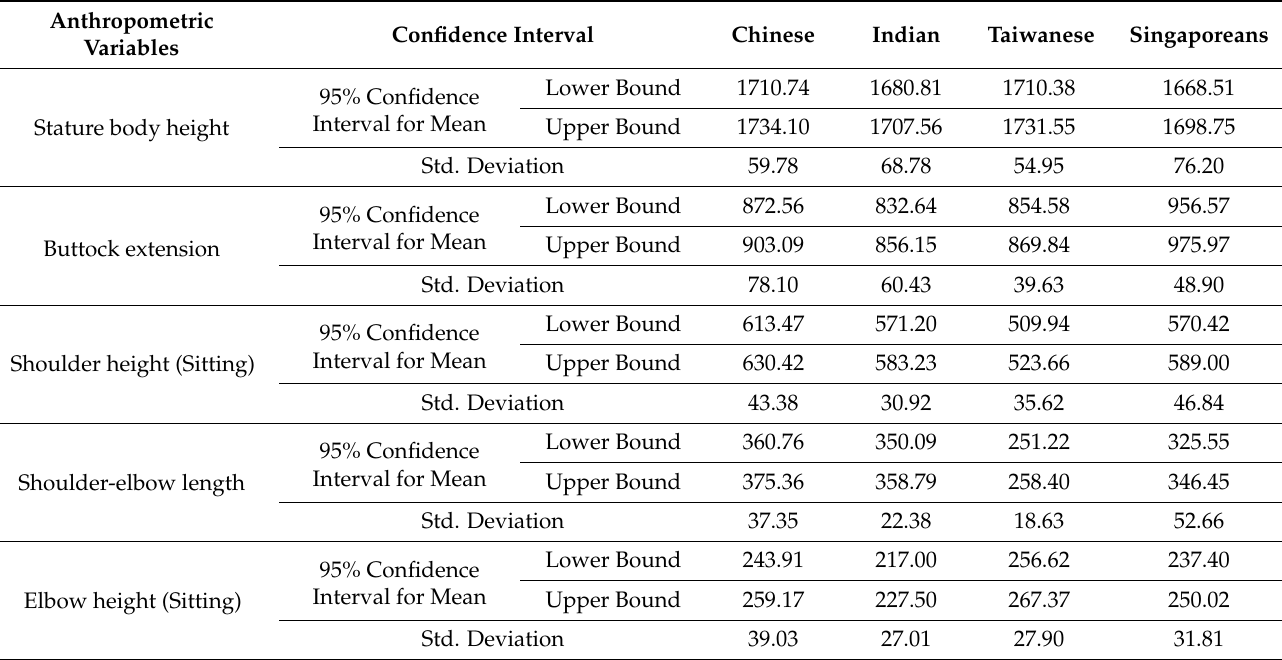
Table A1. Additional descriptive statistics. Note: All measurements are in mm unless